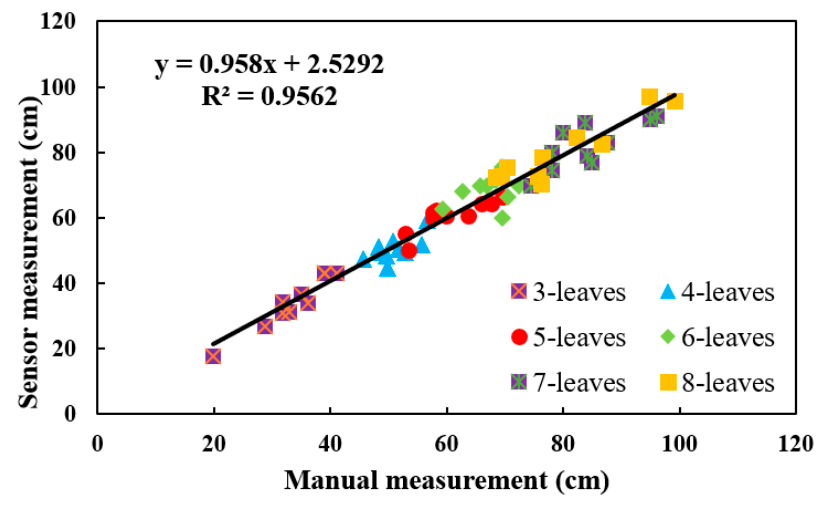
Figure 13. Effectiveness of the calculation method for phenotypic traits.